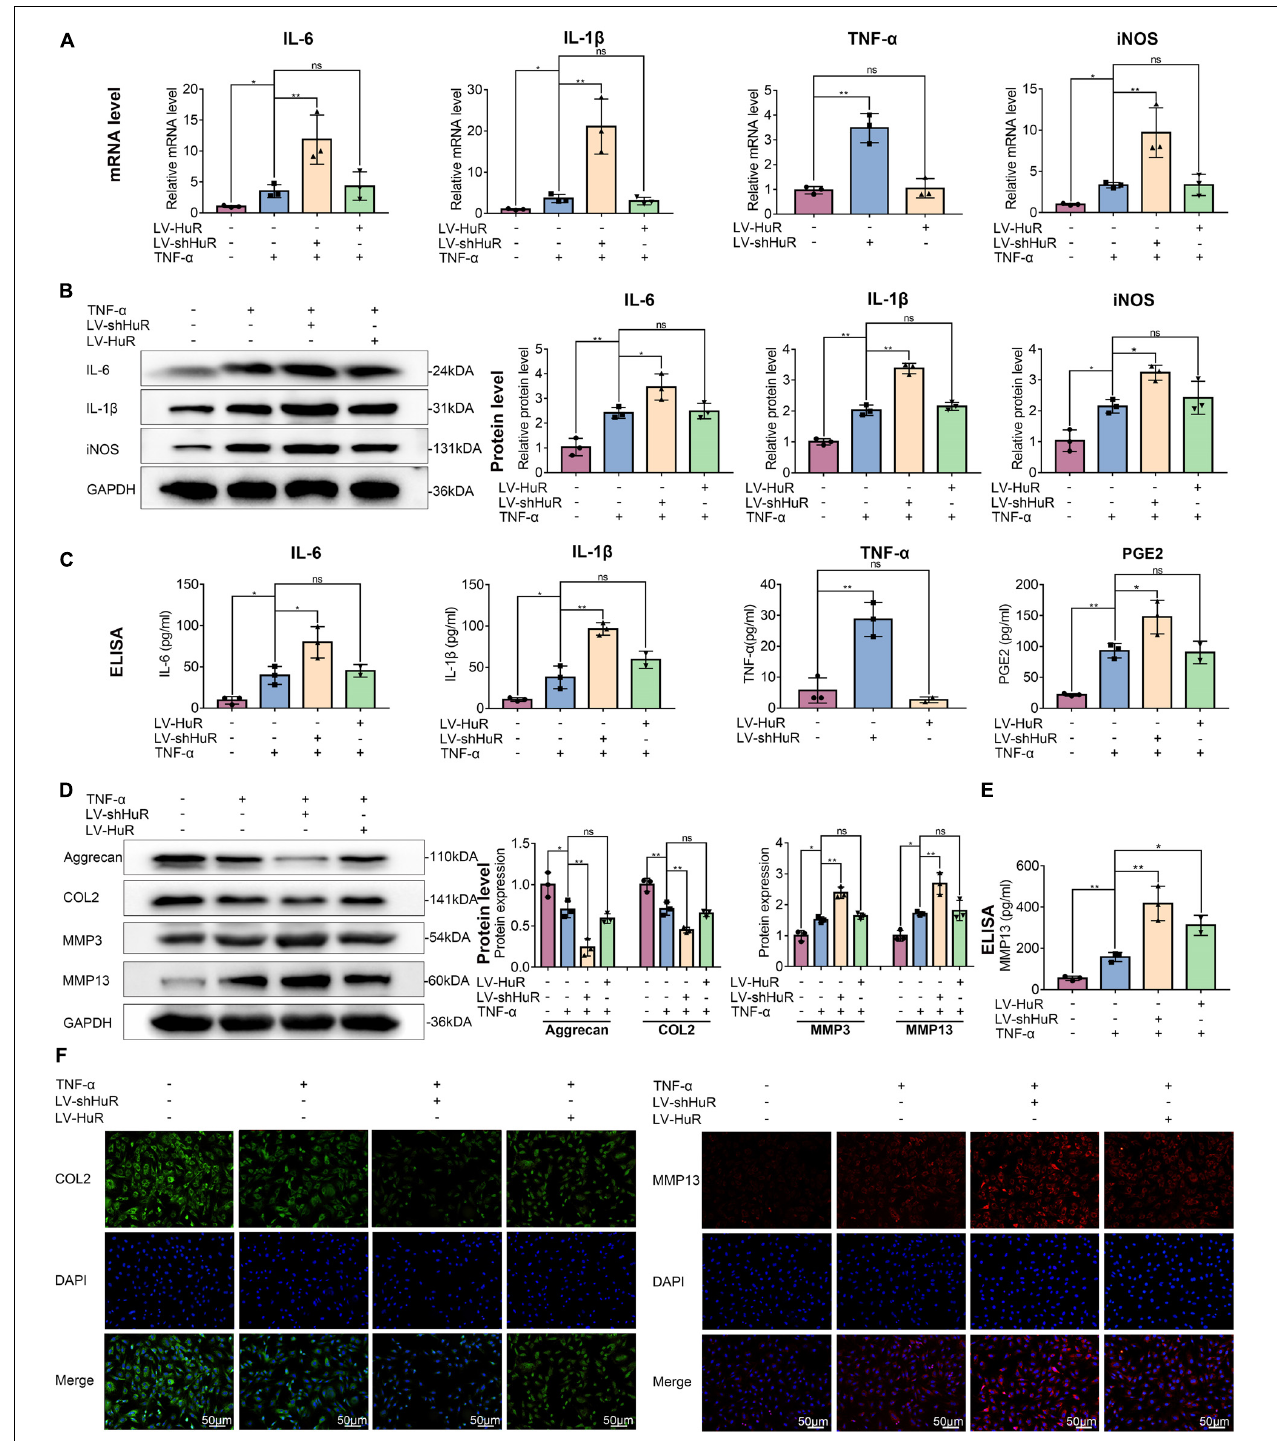
FIGURE 2 | HuR regulates inflammation and ECM degradation in TNF- α -treated NP cells. The cells were transfected with LV-NC, LV-shHuR, or LV-HuR before TNF- α treatment. (A) The gene expression of inflammatory cytokines, such as IL-6, IL-1 β , TNF- α , and iNOS, was detected, with or without TNF- α treatment and added lentivirus. (B,C) The protein expressions of inflammatory cytokines were detected by Western blot and ELISA. (D) The protein expressions of ECM biosynthesis and ECM breakdown proteins, such as Aggrecan, COL2, MMP3, and MMP13, were detected by Western blot. (E) The expressions of MMP13 detected by ELISA. (F) The COL2 and MMP13 were detected by immunofluorescence combined with DAPI staining for nuclei (scale bar: 50 µ m). All data were shown as mean ± SD ( n = 3). * p < 0.05, ** p < 0.01.